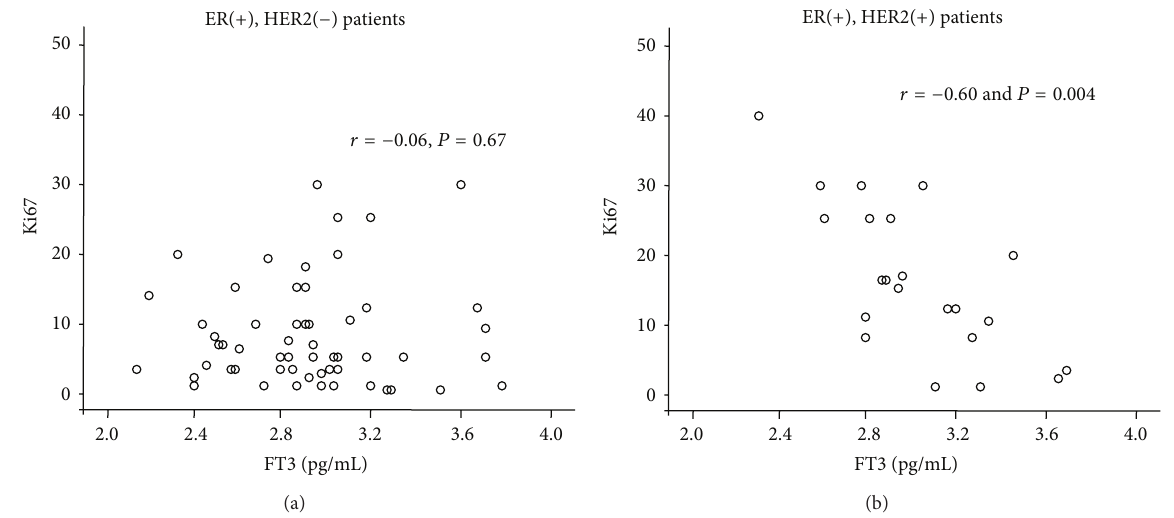
Figure 2: Scatterplots showing correlation between proliferation index Ki67 and FT3 in breast cancer patients including either (a) HER2( − ) or (b) HER2(+) tumors. A correlation exists between Ki67 and FT3 only in HER2(+) breast cancer patients.